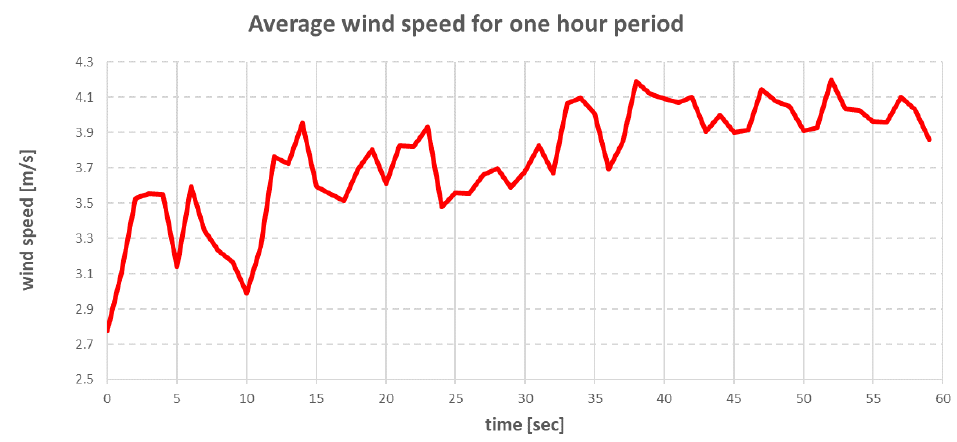
Figure 20. Wind speed changes during simulation.